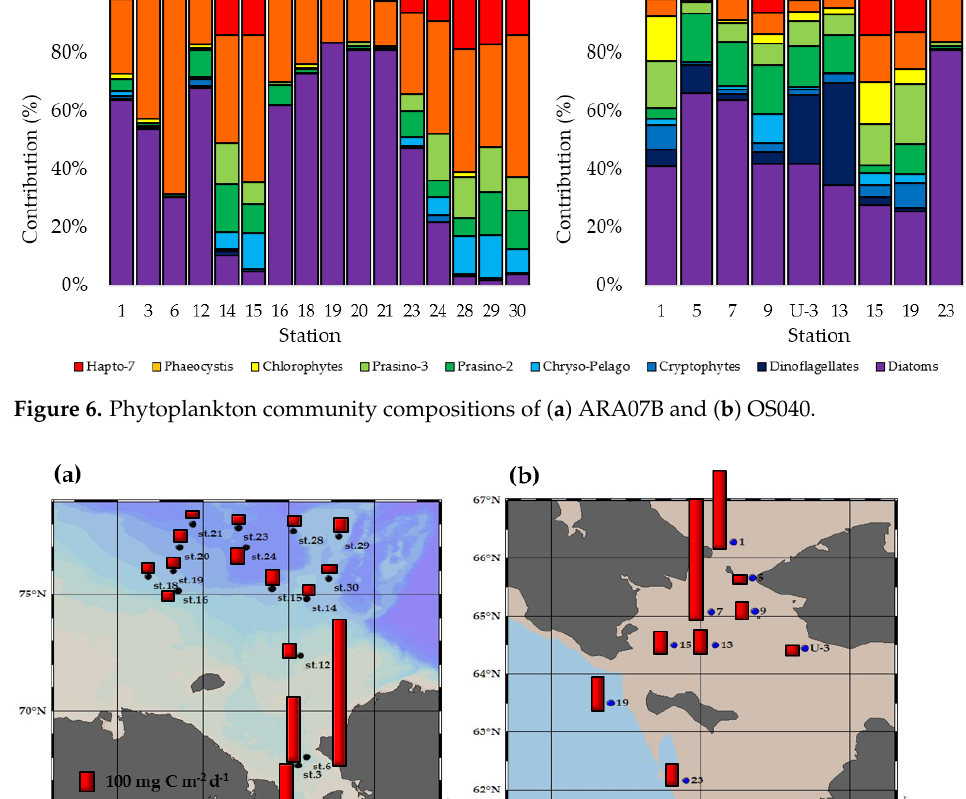
50 mg C m -2 d -1